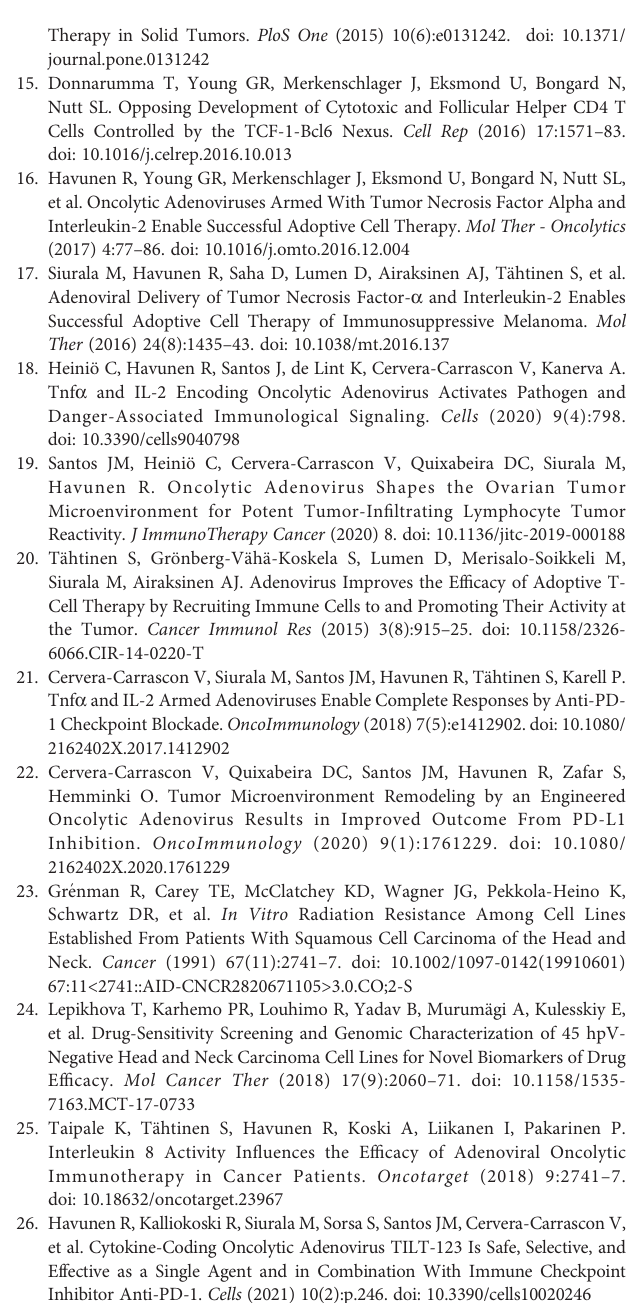
Supplementary Figure S3B, C | Correlation analysis of TILT-123 E1a (D24) expression vs IL-2/TNF a secretion following infection of HNSCC patient derived cell lines. Spearman non-parametric correlation analysis between E1a expression and IL-2 3b production and 3c TNF a production from TILT-123 infected HNSCC cell lines. Supplementary Figure S4A, B | Immunohistochemistry of tumors from respective treatment groups from MOC1 anti-PD-1/PD-L1 refractory animal experiment. The treatment groups included ICI monotherapy, Ad5-Luc + ICI control, Ad5-CMV-mTNF a /mIL-2 monotherapy and Ad5-CMV-mTNF a /mIL-2 + ICI combination therapy.Tumorsfrom respective groups were fi xed,paraf fi n embedded and stained for H&E and CD3 (brown).